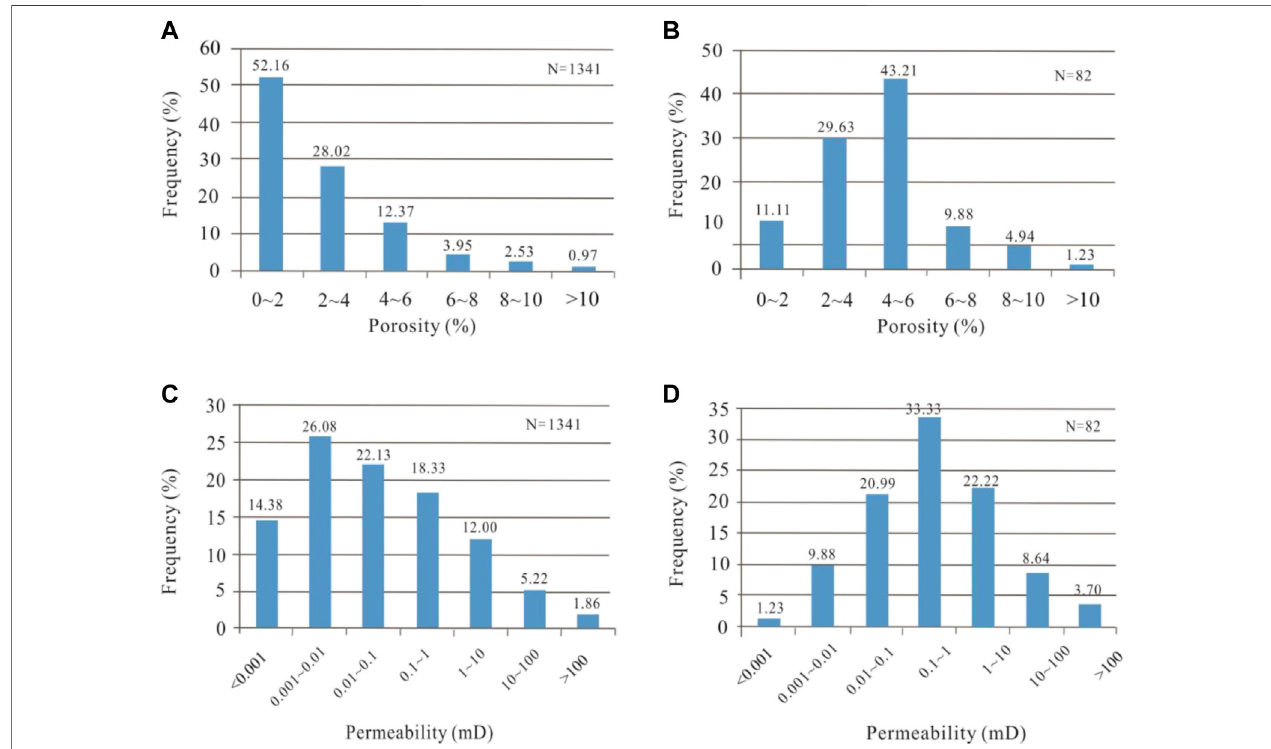
FIGURE 9 | Histogram of porosity and permeability distribution of Longwangmiao Formation in central-southwestern Sichuan Basin.